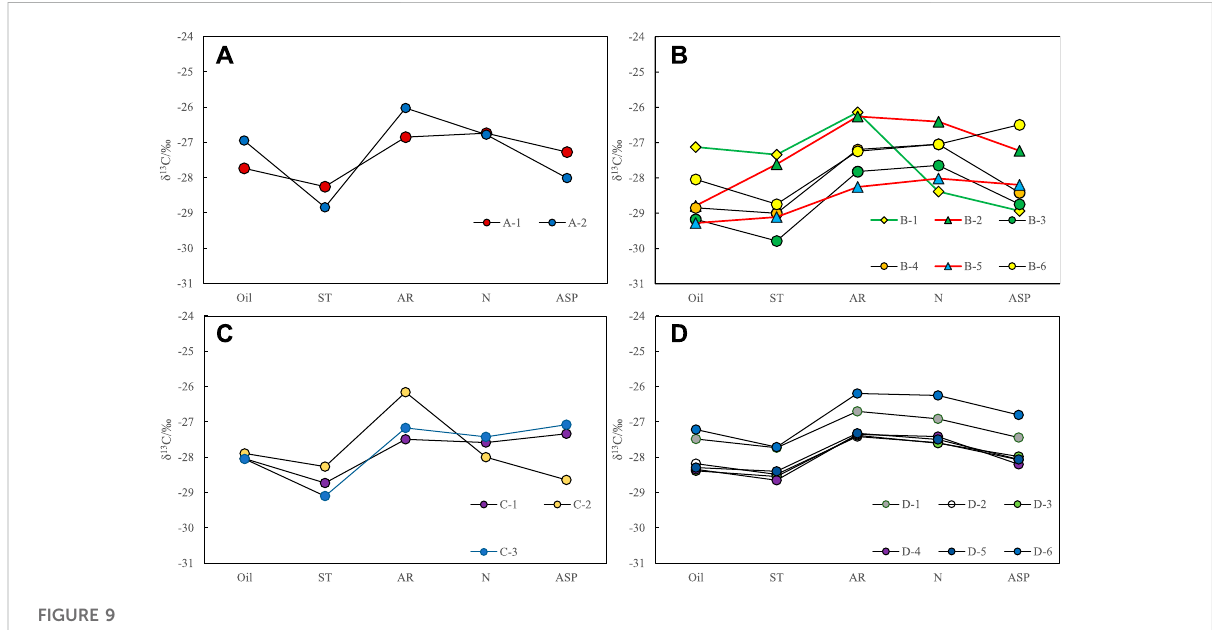
FIGURE 9 Characteristics of carbon isotopes of crude oil components in Qinnan